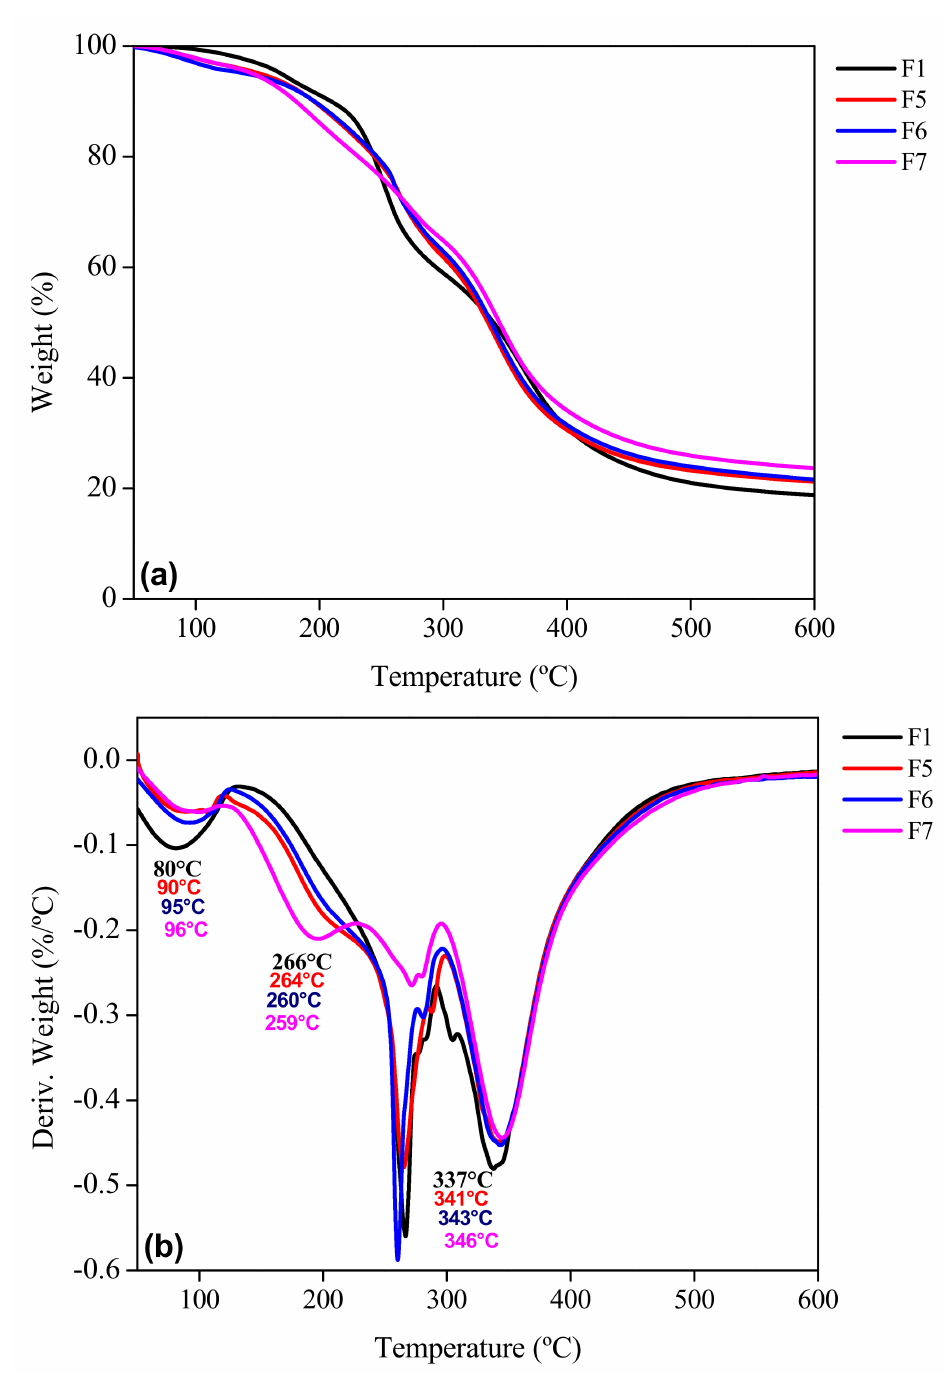
Figure 9. TGA profile of the reinforced gelatin biofilms. ( a ) Weight as a function of temperature and ( b ) first derivative of the weight curve. F1: control biofilm; F5–F7: biofilm with